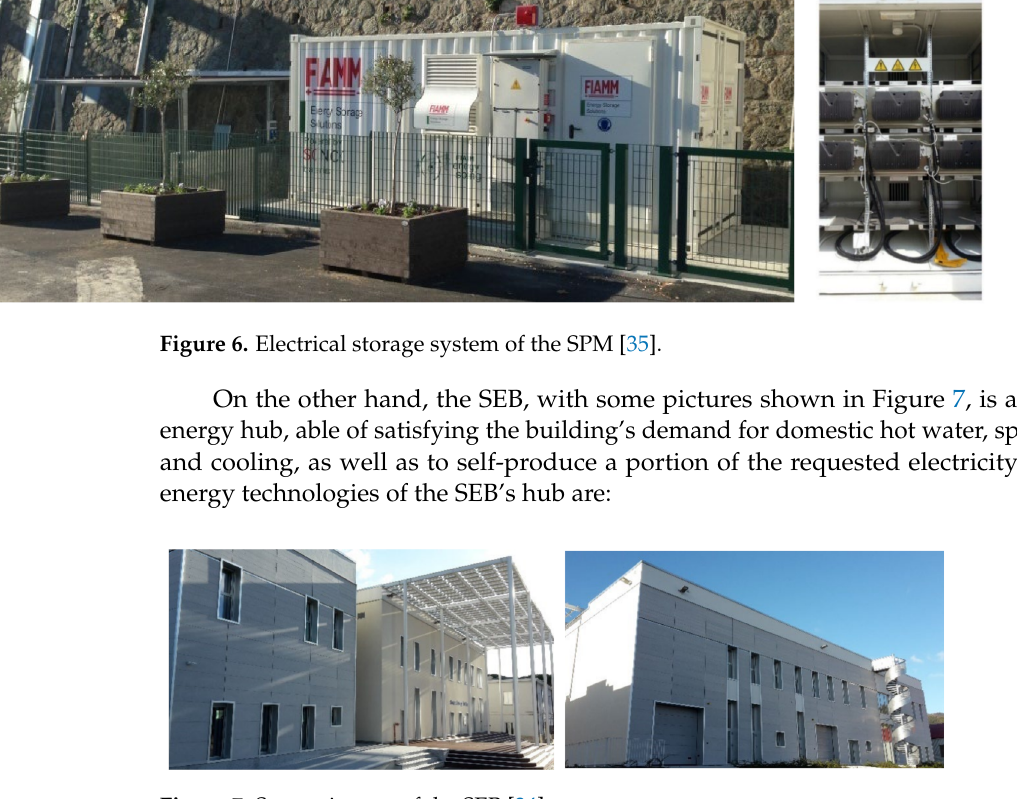
Figure 7. Some pictures of the SEB